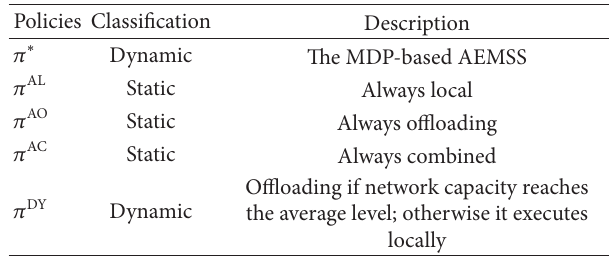
Table 4: Offloading decision policies adopted in the performance